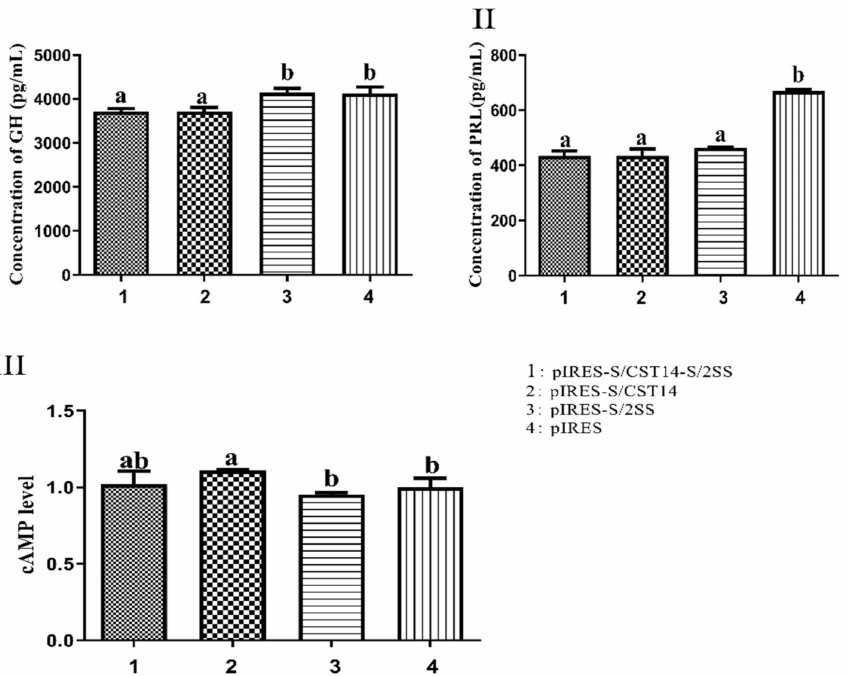
Figure 3. ( I , II ) The GH and PRL concentrations in GH3 cells transfected with four various plasmids for 48 h. ( III ) The intracellular cAMP accumulation in GH3 cells transfected with four various plasmids for 48 h. The results are expressed as the mean ± SEM. The same letters on the bar represent no significant difference, different letters on the bar represent significant difference at p <